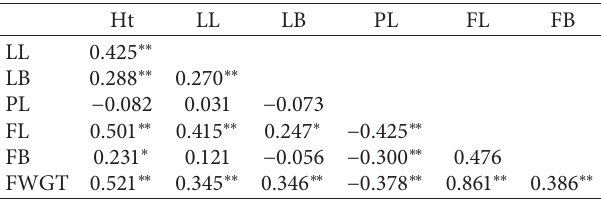
Table 5: Correlation between quantitative traits of doum palm from